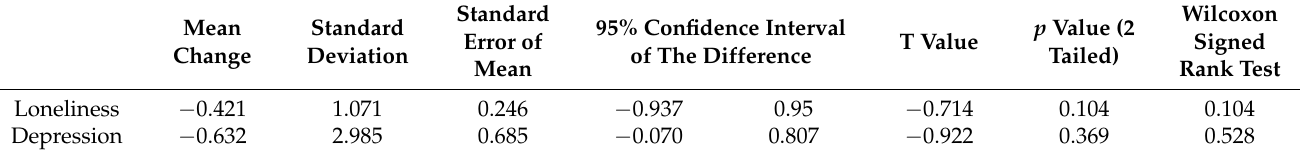
Figure 3. Change over time between T1 and T2 ( n = 19) in loneliness. Table 6. Mean Change Between T1 and T2 in Loneliness and Depression.